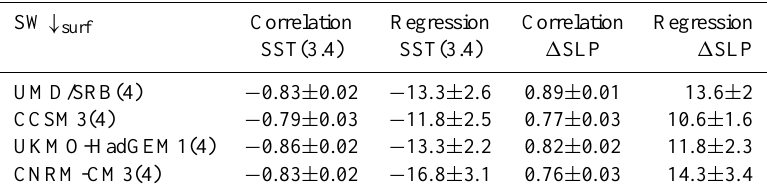
Table 2. Correlation coefficients, and their error interval, between shortwave SW ↓ surf averaged over El Ni˜no 4 region and sea surface temperature SST averaged over El Ni˜no 3.4 region; and the 1 SLP or the difference in sea level pressure over (160 ◦ W to 80 ◦ W, 5 ◦ S to 5 ◦ N) and over (80 ◦ E to 160 ◦ E, 5 ◦ S to 5 ◦ N). Regression coefficients, and their error interval, between SW ↓ surf and SST in Wm − 2 per degree; and between SW ↓ surf and 1 SLP in Wm − 2 per hPa.